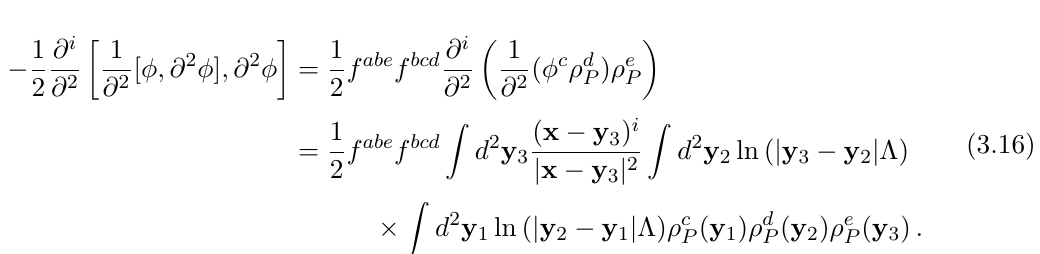
Figure 6 . Two sets of diagrams contributing to order- g 5 WW field α i,a, (5) position x by three color sources at transverse position y different orderings of gluon exchanges are not